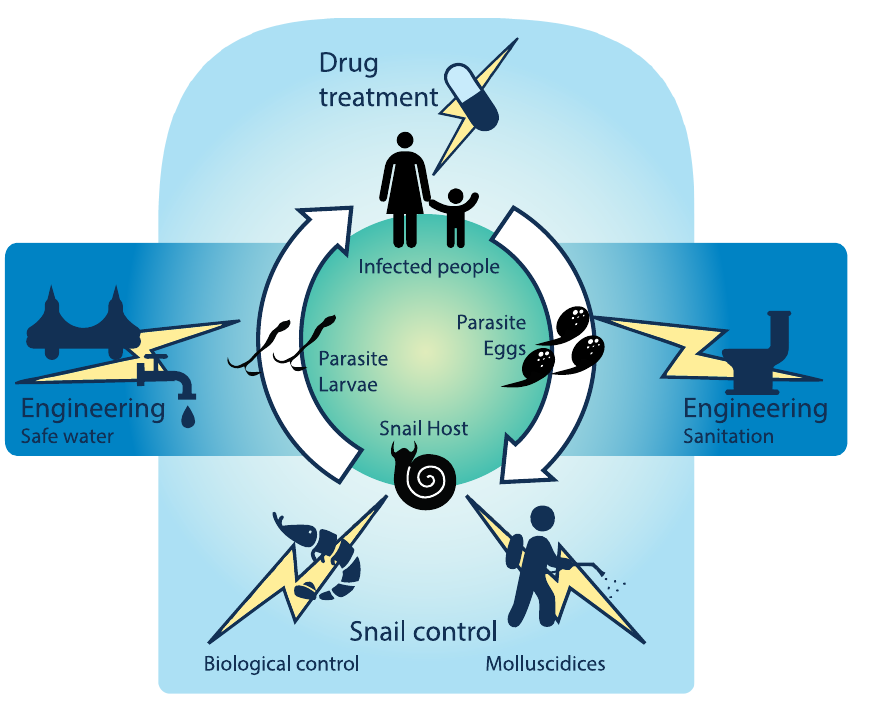
Fig 1. Control strategies used against schistosomiasis during the past